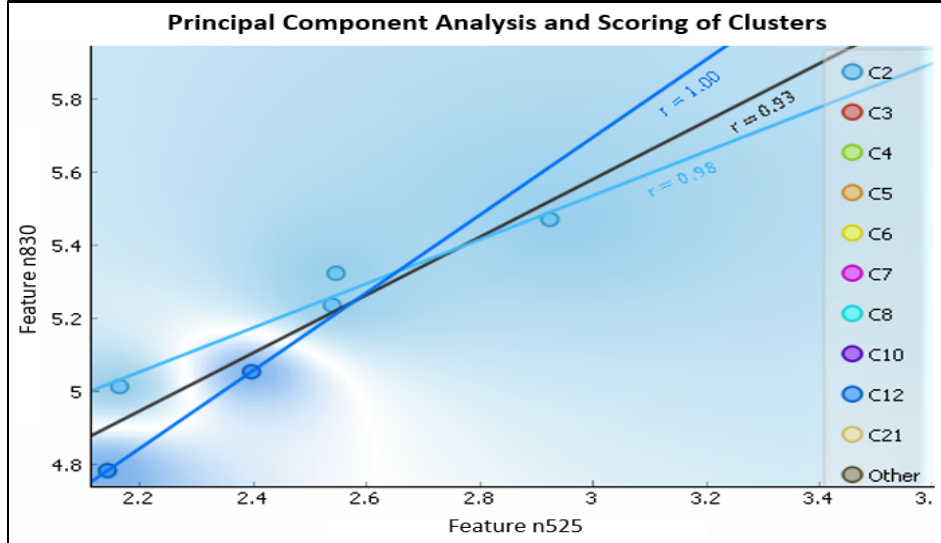
Figure 10. Features-based Principal Component Analysis and scoring of clusters. Features n525 and n830 are indicated on the X- and Y-axes, respectively. The clusters are colour coded, and the colour of each regression line on the graph matches the colour on the cluster legend on the right.